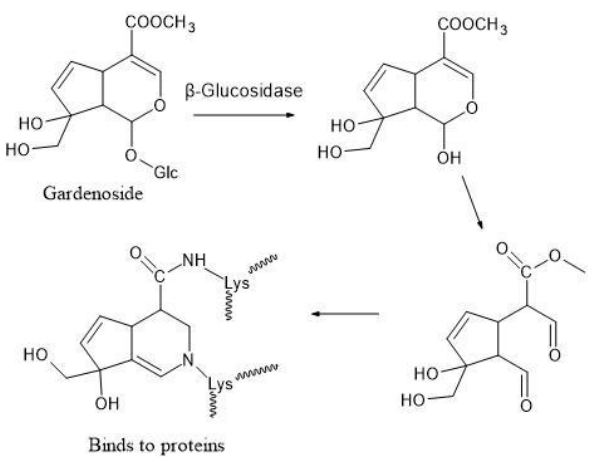
Figure 7. Mechanism by which gardenoside induces binding with proteins of transporters.